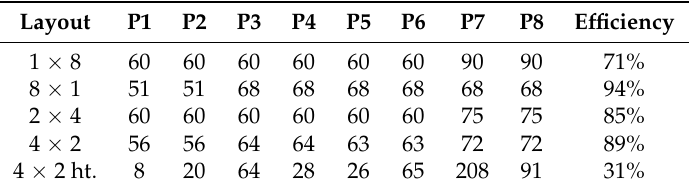
Table 1. Workload, in number of CTUs, for the partitioning of a Full HD frame into 8 tiles.